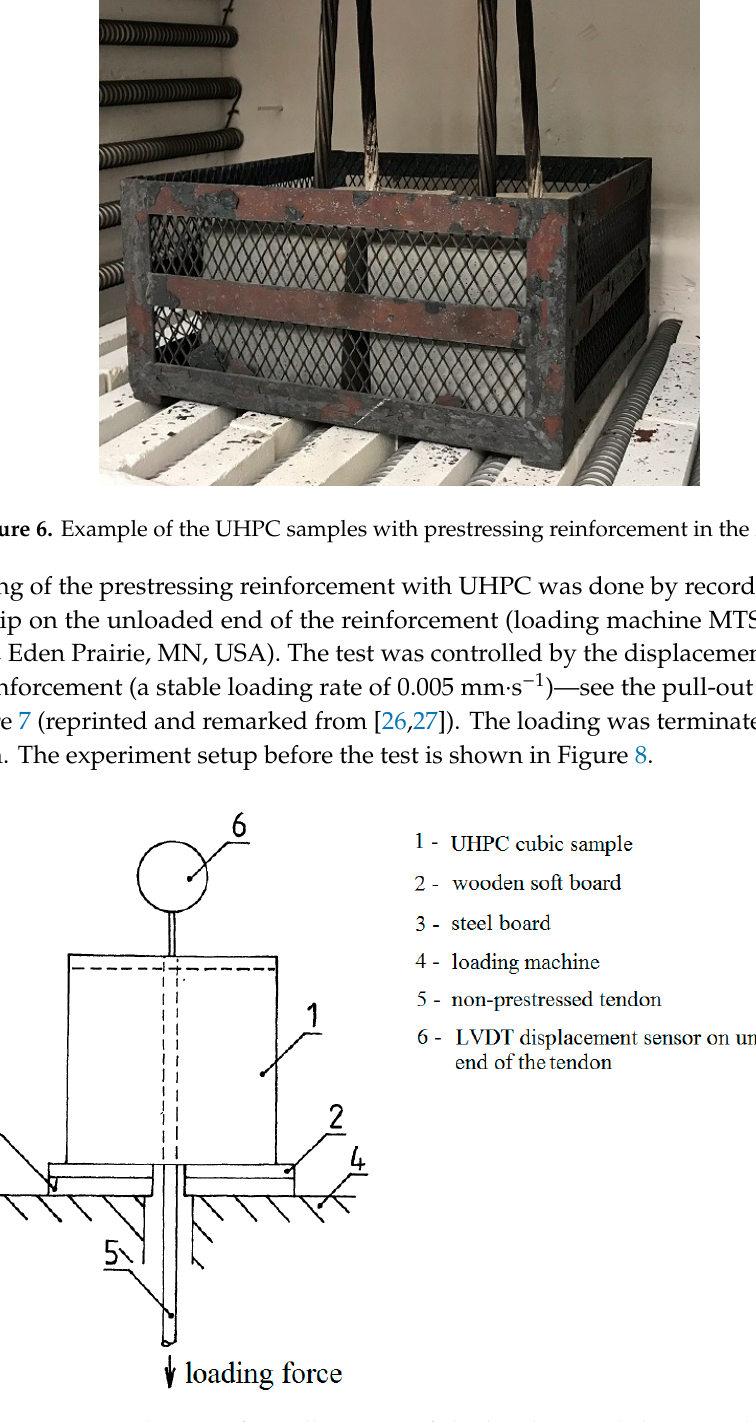
Figure 7. Experimental setup of a pull-out test of the bond strength between the prestressing reinforcement (non-prestressed tendon) and concrete.